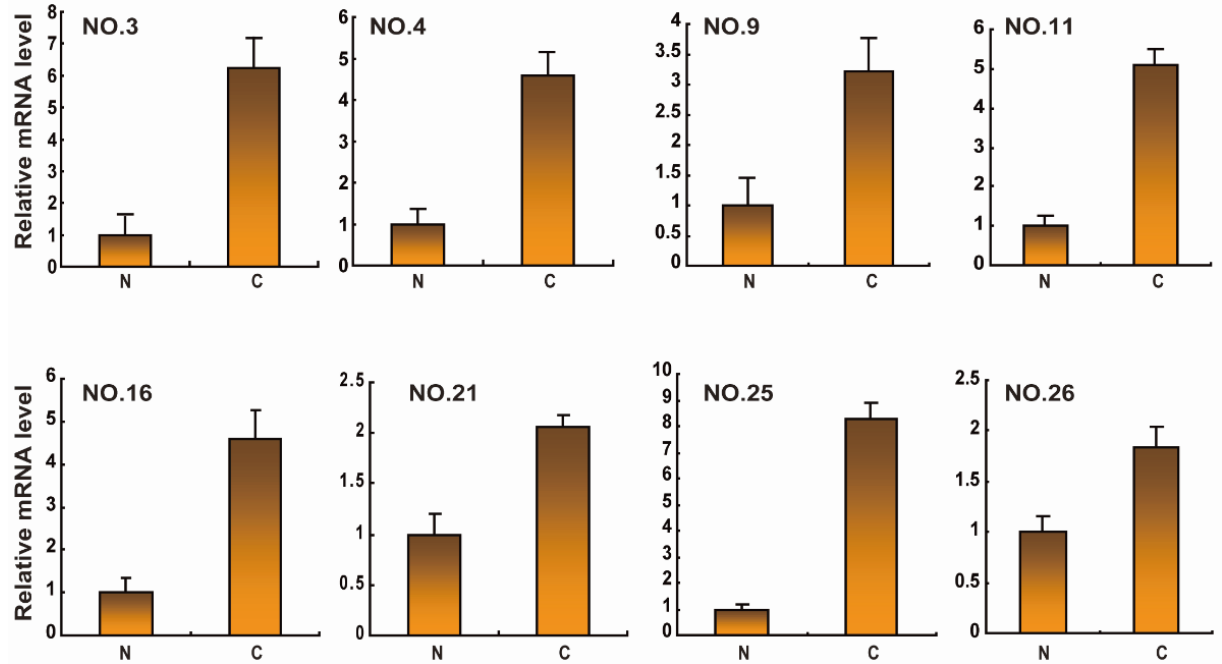
Figure 3. The mRNA expression of SOX2 in ACC. Evaluation of the expression of the indicated mRNA using quantitative polymerase chain reaction (qPCR). Lysates of 30 ACC cancer tissues (C) and matched adjacent non-cancerous tissues (N) pairs were analyzed using real-time polymerase chain reaction (PCR). The representative eight pairs are shown.